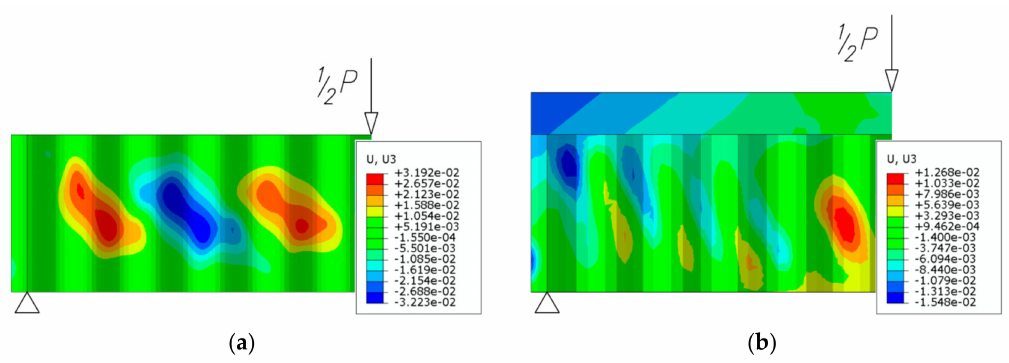
Figure 18. Final distribution of displacements u z in the transverse plane of the web (unit: m): ( a ) steel beam; ( b ) beam bonded to the reinforced concrete